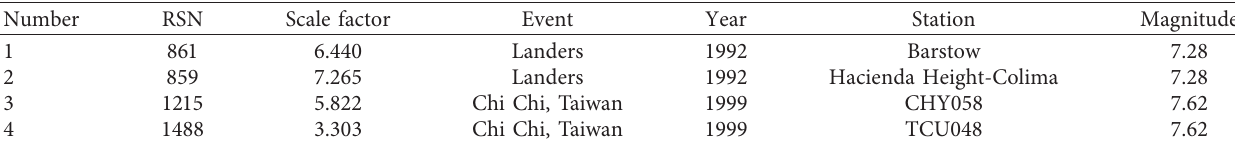
Table 3: Selected records and scale